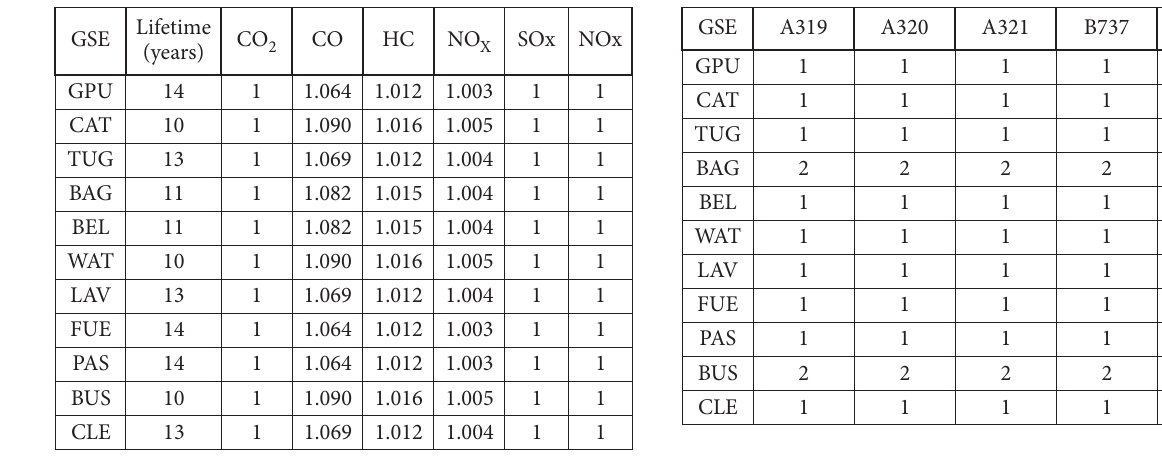
Table 8. Number of vehicles required per analyzed